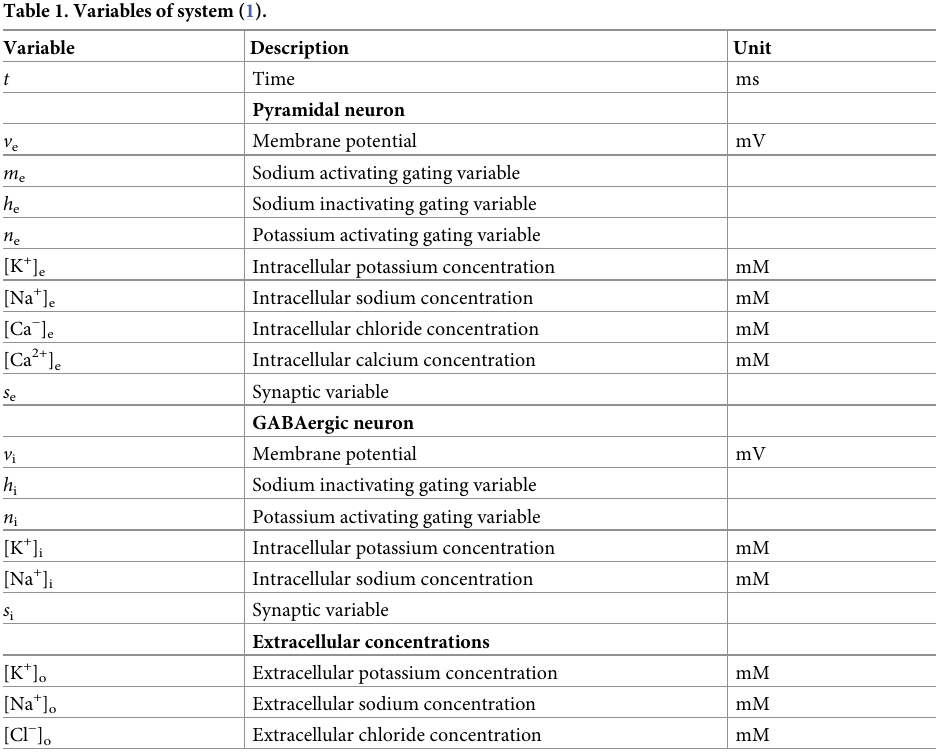
Table 1. Variables of system